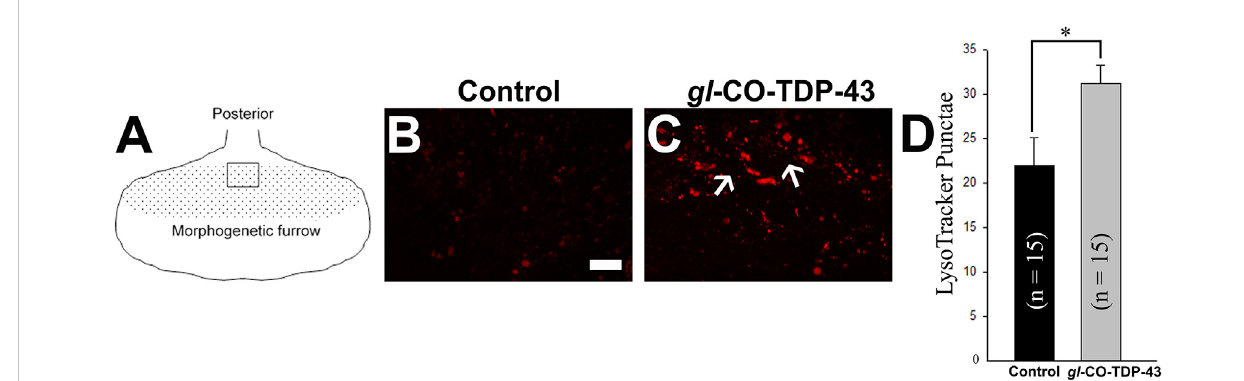
FIGURE 5 TDP-43 misexpression leads to increased lysosomal vacuoles positive for autophagy markers. (A) Schematic of the third instar larvae and the area imaged. Live staining of the LysoTracker dye shows increases in lysosomal punctae in gl -CO-TDP-43 fl ies (C) compared to control (B) . Scale bar equals 10 µm. (D) shows quanti fi cation of (B, C) , n = 15 and p = 0.02. Genotypes: (B) Canton S, (C) w 1118 /+; gl -TDP-43 CO /+;